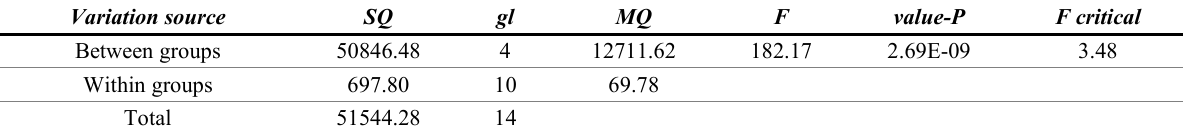
Table 5. ANOVA – Phase 1, only compositions with 0.25 water/cement ratio – the influence of granular skeleton. Variation source SQ